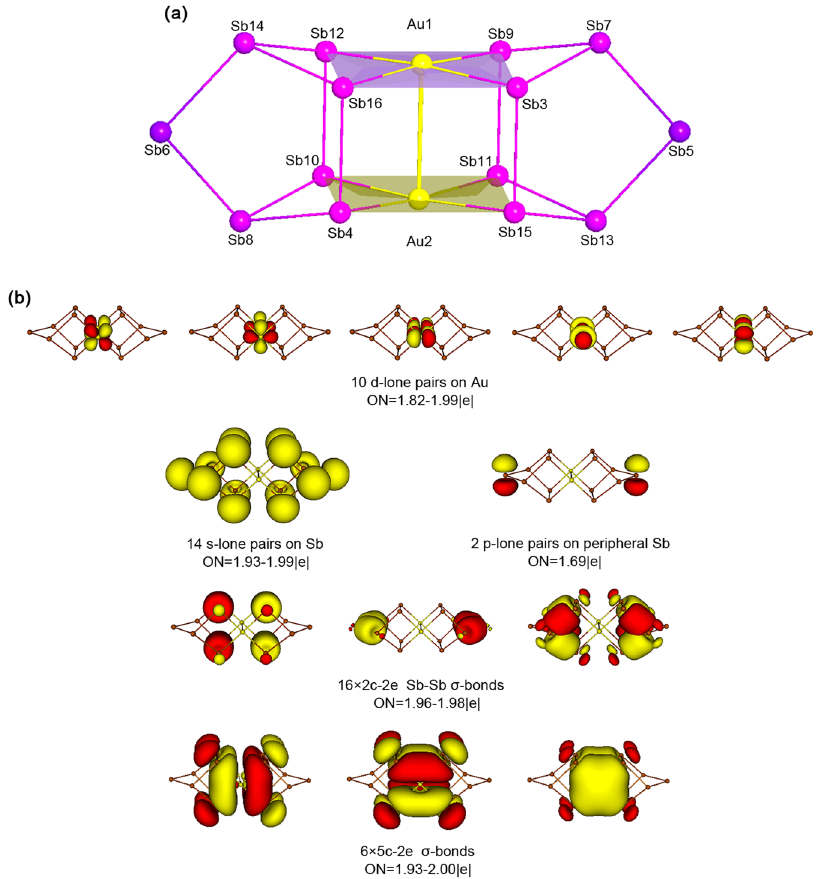
Figure 4. Model cluster [Au 2 Sb 14 ] 4 − ( 2 ). ( a ) Optimized D 2 h structure at the PBE0/def2-TZVP level. ( b ) Bonding pattern on the basis of AdNDP analysis. Occupation numbers (ONs) are